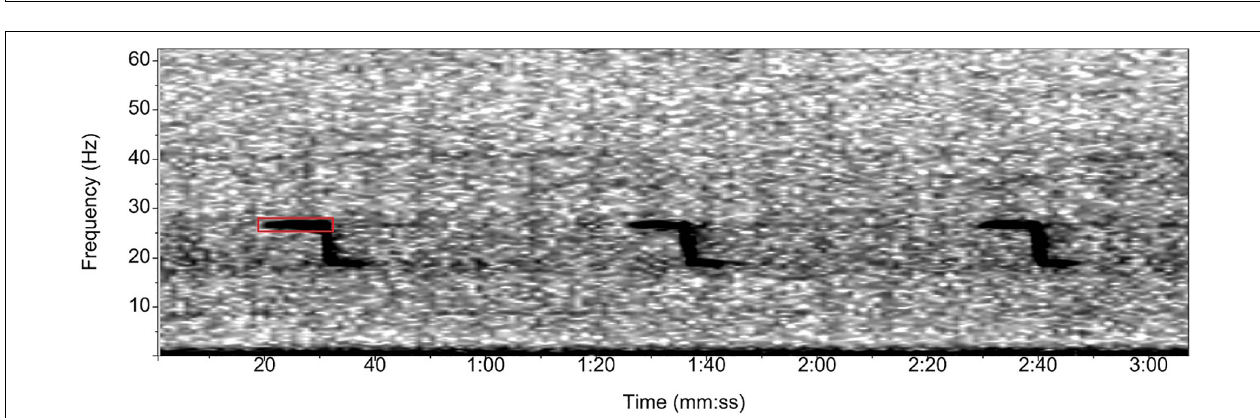
FIGURE 4 | Spectrogram of a series of Antarctic blue whale z-calls. The first unit of the z-call is highlighted by the red box. This unit was targeted by the automated energy-ratio detector in Ishmael. Spectrogram parameters: Hamming window, 1,024 points FFT length, 50% overlap.